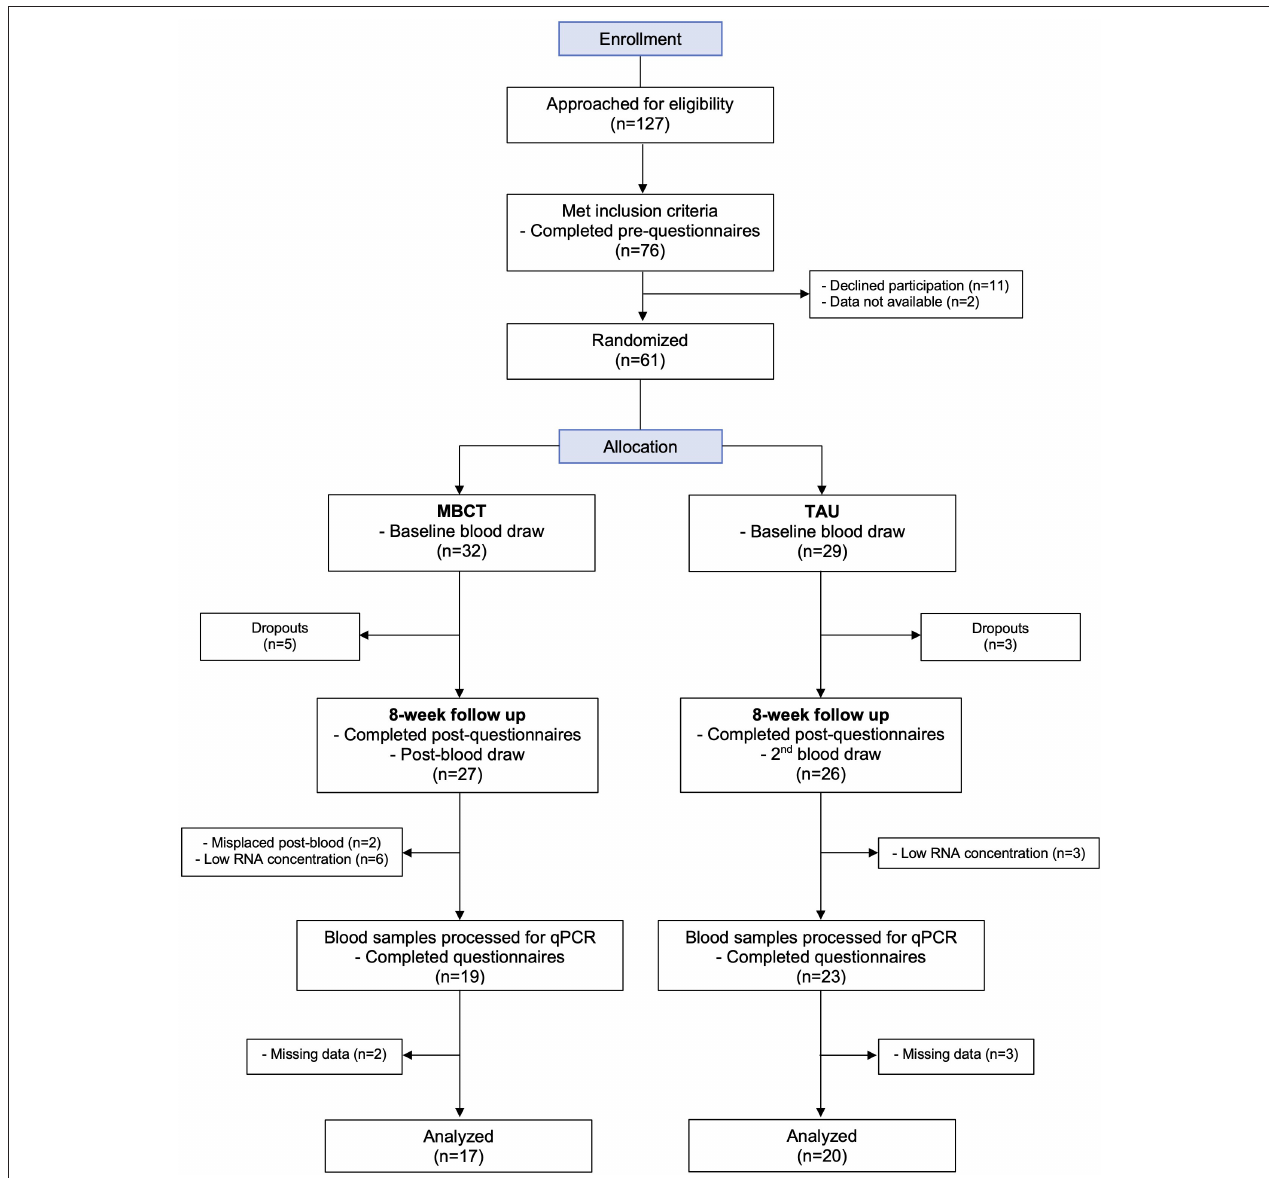
FIGURE 1 | Participant flow chart. MBCT, Mindfulness Based Cognitive Therapy treatment group; TAU, Treatment as usual